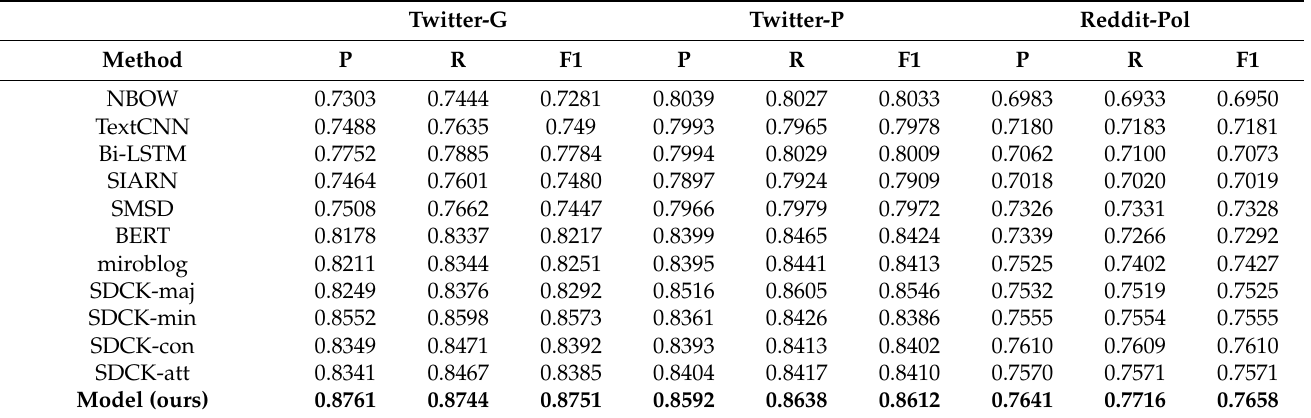
Table 3. Comparison results for sarcasm detection. The best result is in boldface. Twitter-G Twitter-P